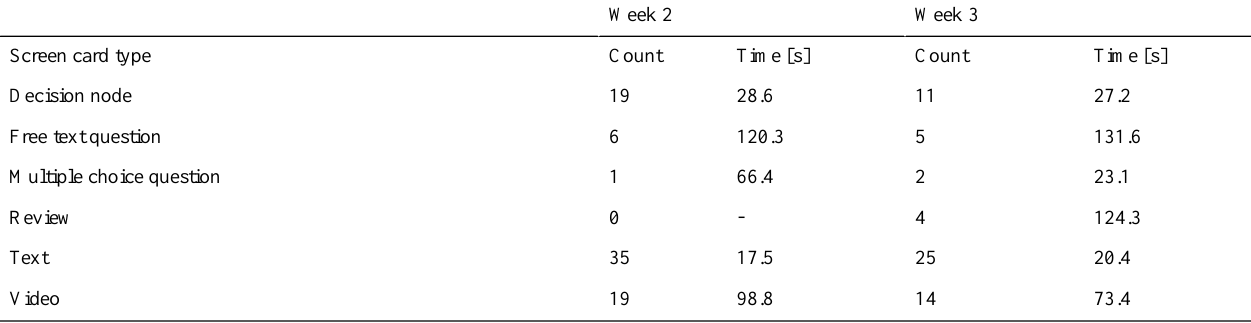
Table 1. Average time spent on screen card